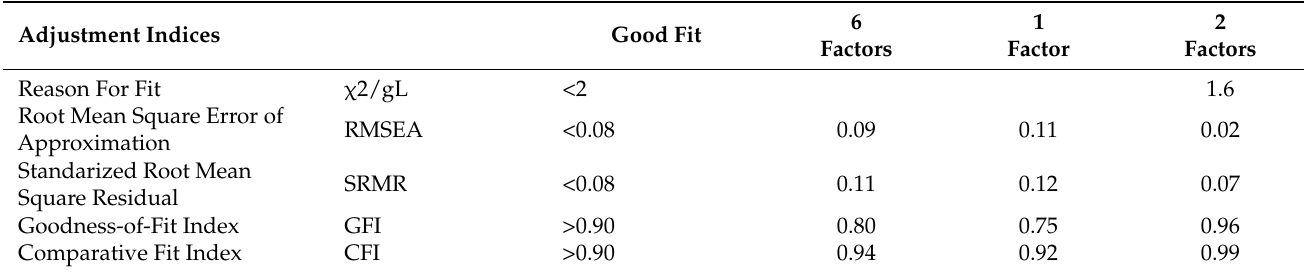
Table 3. CFA Adjustment Indices.3.1.1.